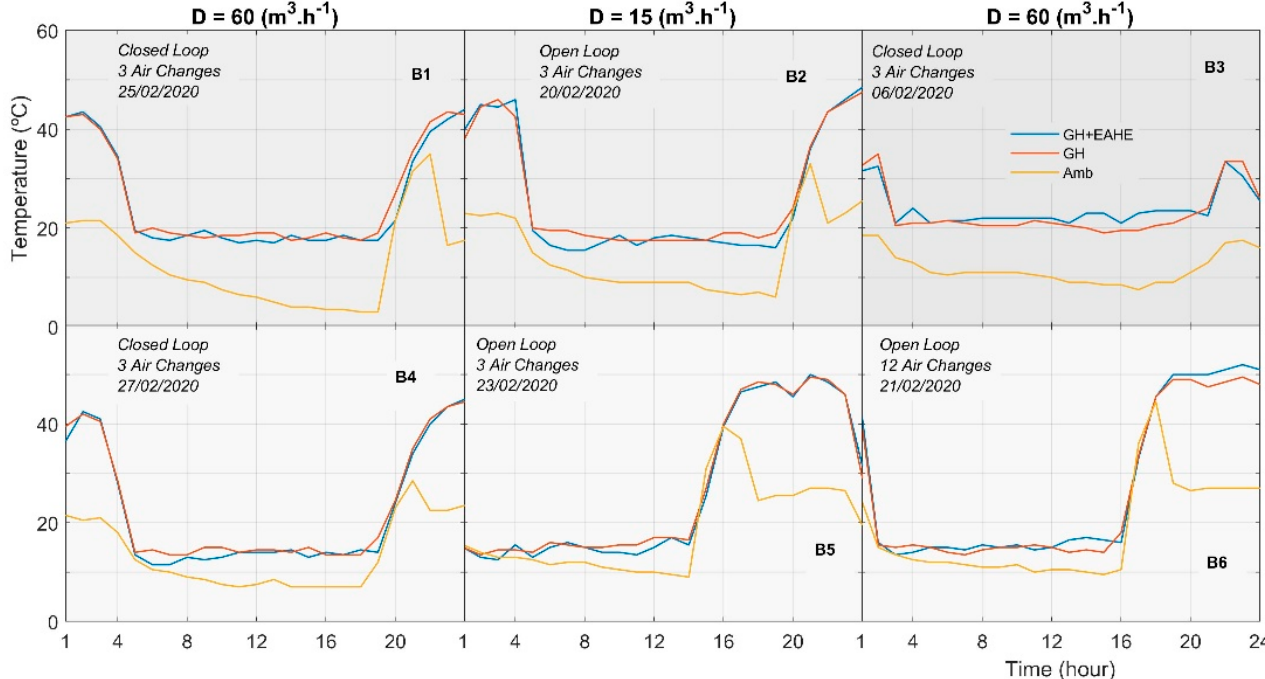
Figure 4. GHs air temperature/humidity variation during the experiences periods (heater device: Off).